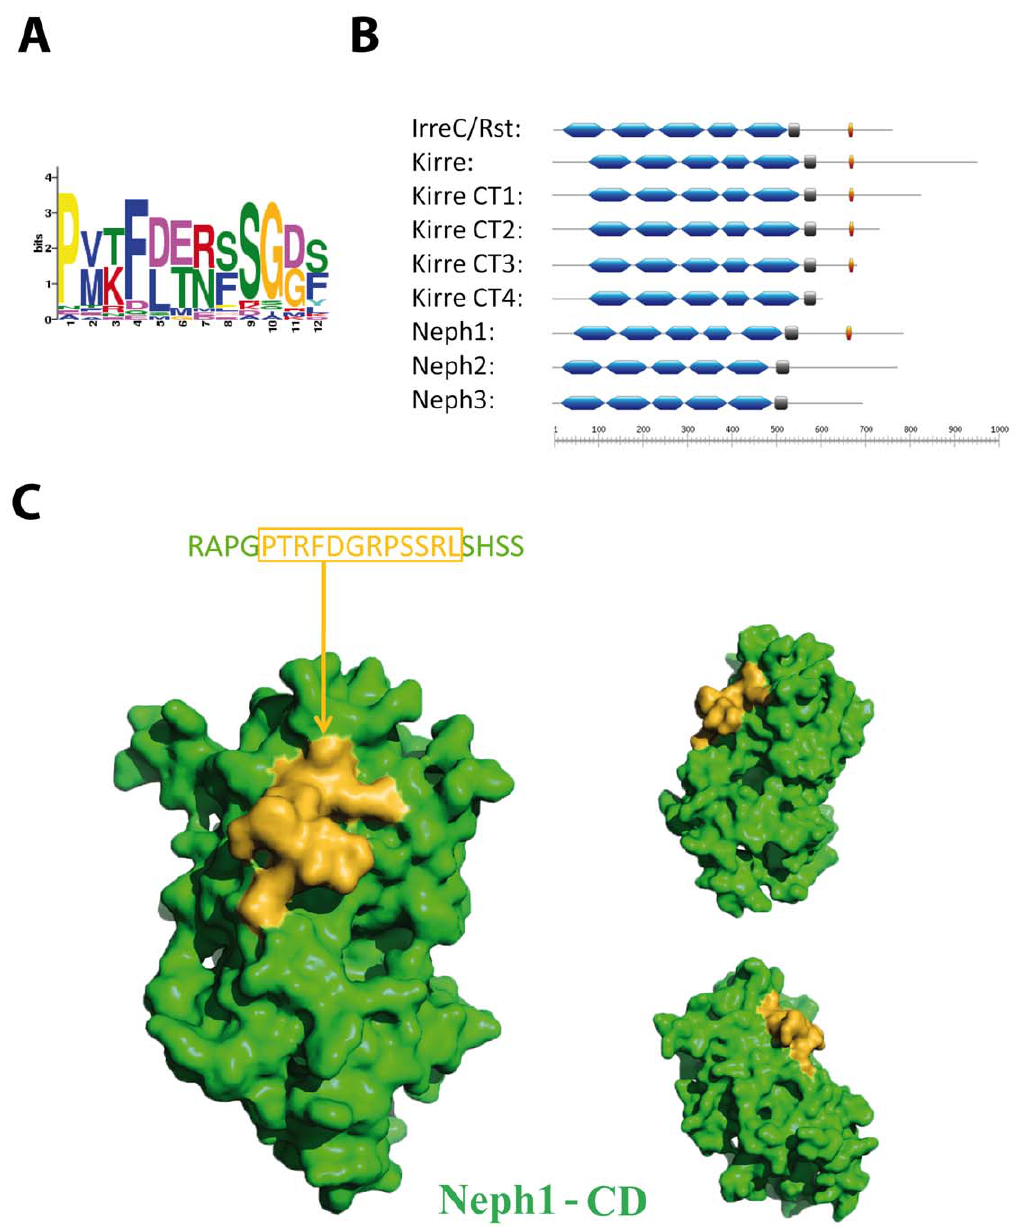
Figure 4. Schematic drawing of the identified KIN1 motif and its position in the protein sequences. A. MEME generated Bitlogo of the KIN1 motif. B. Structural comparison of Neph and Neph-like proteins. Blue: Ig domain. Grey: transmembrane domain. Yellow: KIN1 motif. Scale: number of amino acids. C. Surface representation of the structural model of the cytoplasmic domain of Neph1 is shown in green with the KIN1 motif highlighted in yellow.